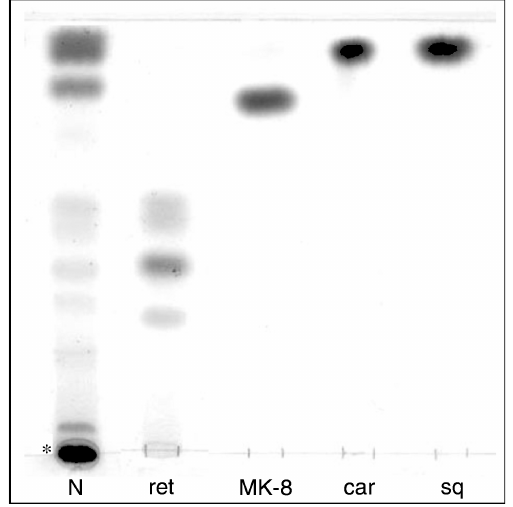
Figure 1. Pigments of Haloquadratum walsbyi cells. Eighty µg of neutral lipid extract (N) was loaded onto a silica gel 60A plate. Asterisk (*) indicates the carotenoid bacterioruberin. Lipid standards: ret = mixture of retinal isomers; MK-8 = vitamin MK-8; car = β -caro- tene; and sq = squalene. Lipids were detected by spraying with 5% sulfuric acid and charring at 120 °C.